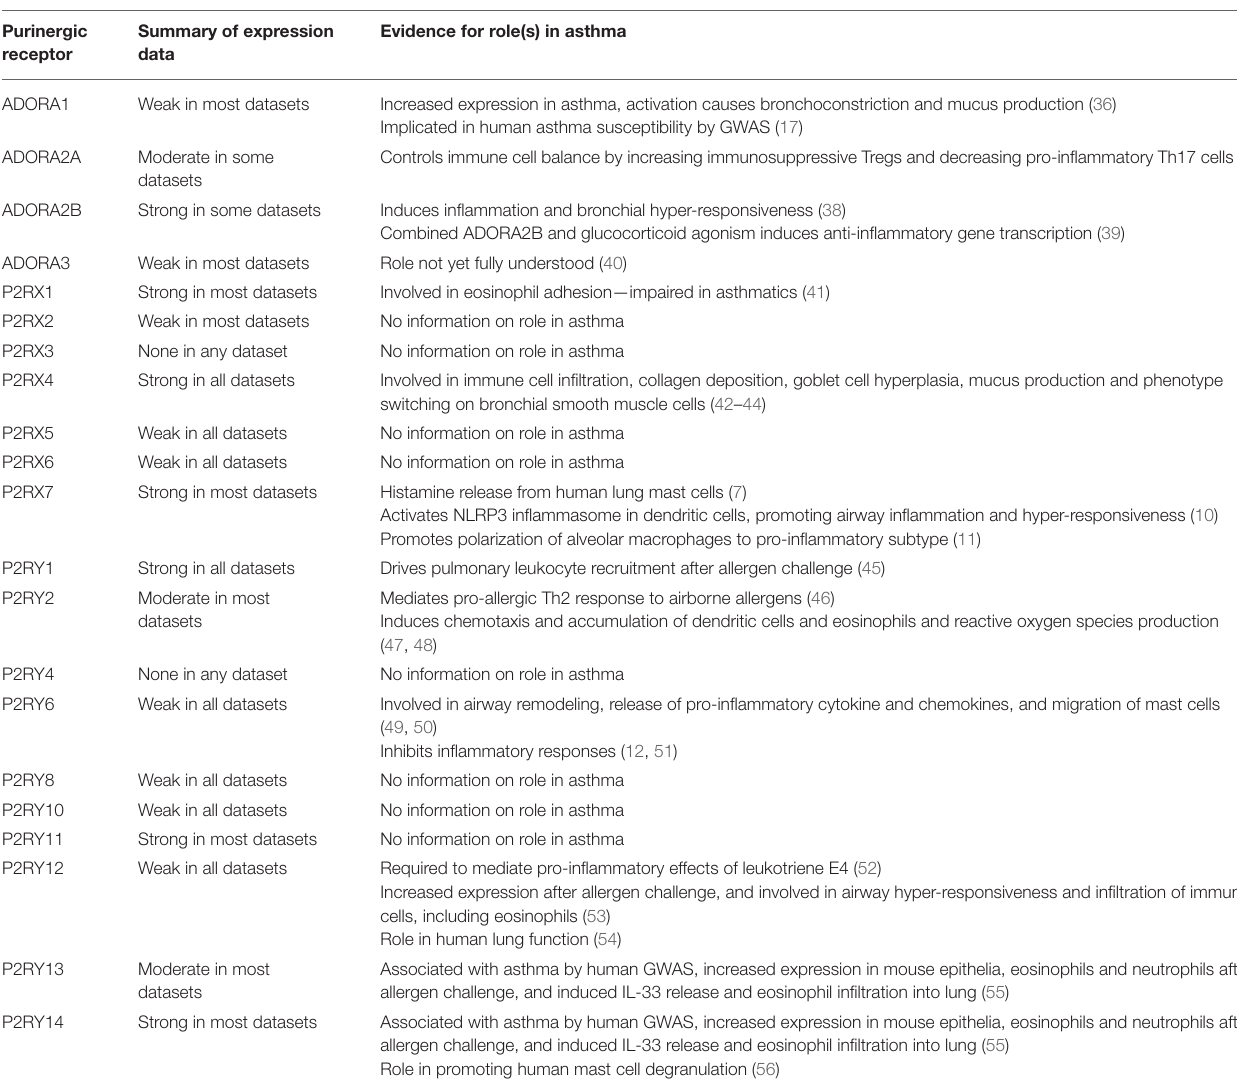
TABLE 4 | Summary of expression data from bioinformatics resources and evidence for the role(s) in asthma pathophysiology from the literature for each purinergic receptor. Purinergic Summary of expression receptor